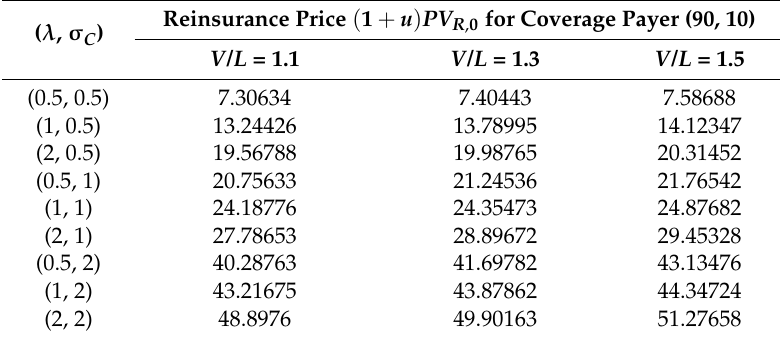
Table 3. Impacts of Catastrophe Intensity and Loss Volatility on